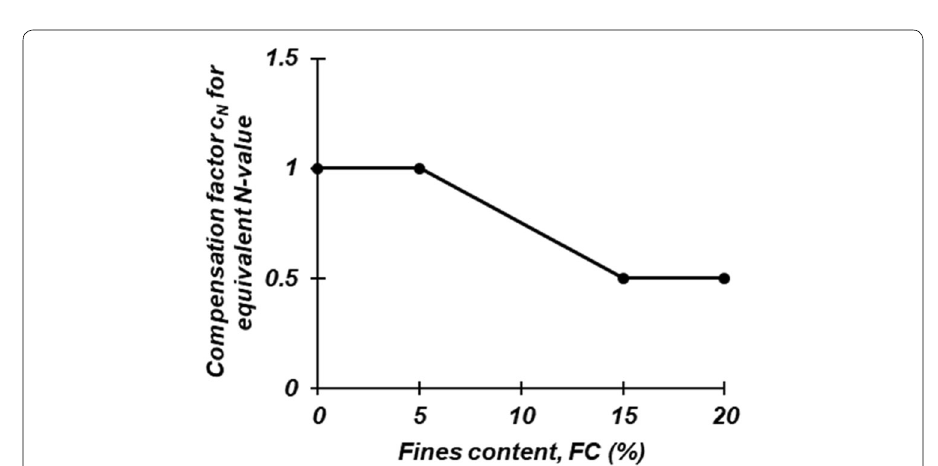
Fig. 11 Compensation Factor for Equivalent N‑Value Corresponding to Fine Contents [9]